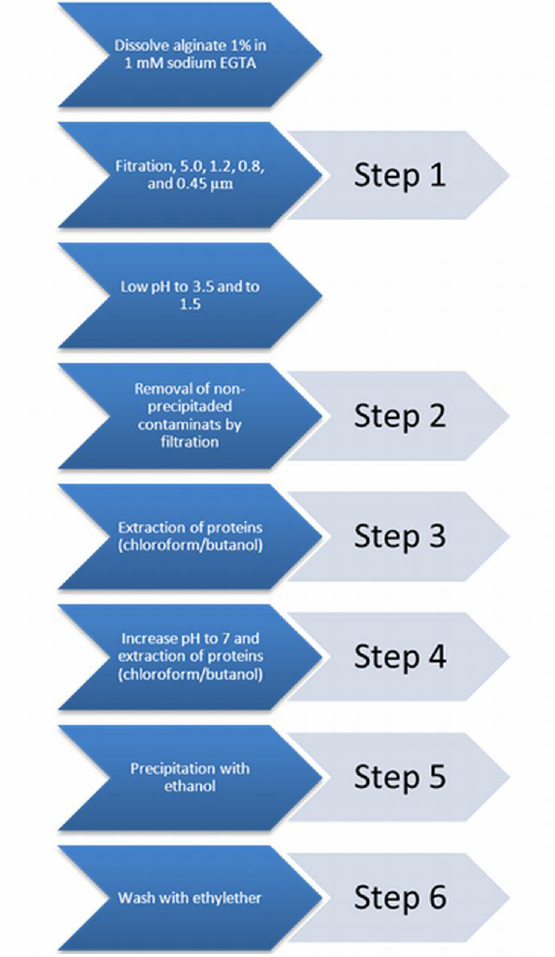
Figure 6. The applied chemical extraction of contaminants of alginate and the six distinct steps in the purification